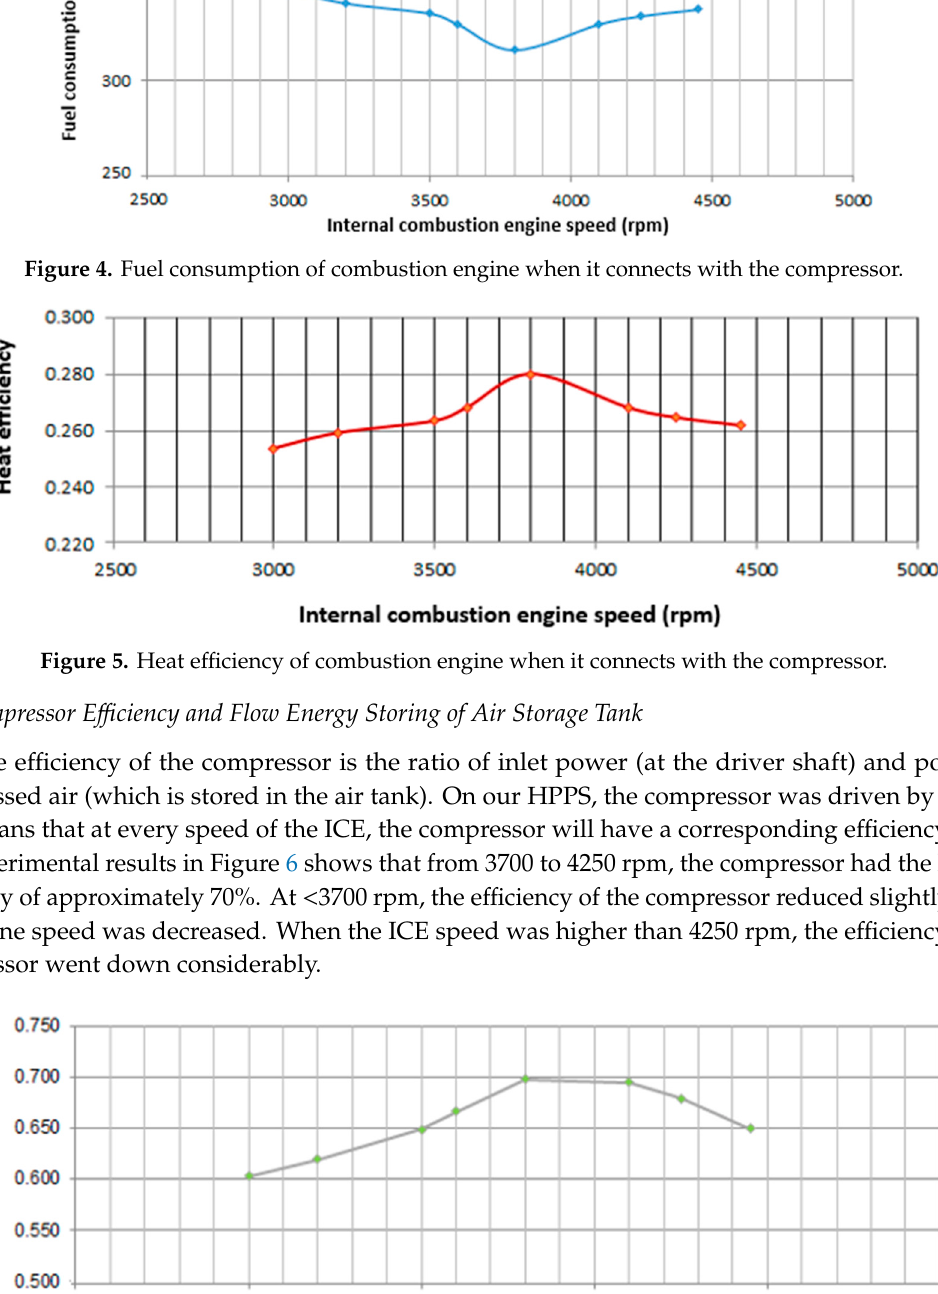
Figure 4. Fuel consumption of combustion engine when it connects with the compressor.